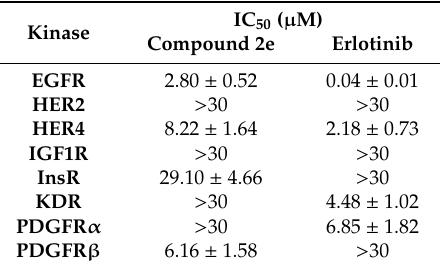
Table 3. The tyrosine kinase inhibition of compound 2e and erlotinib.